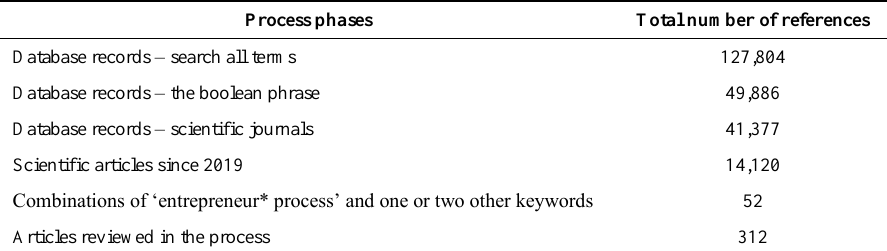
Table 1. Systematic scoping review process